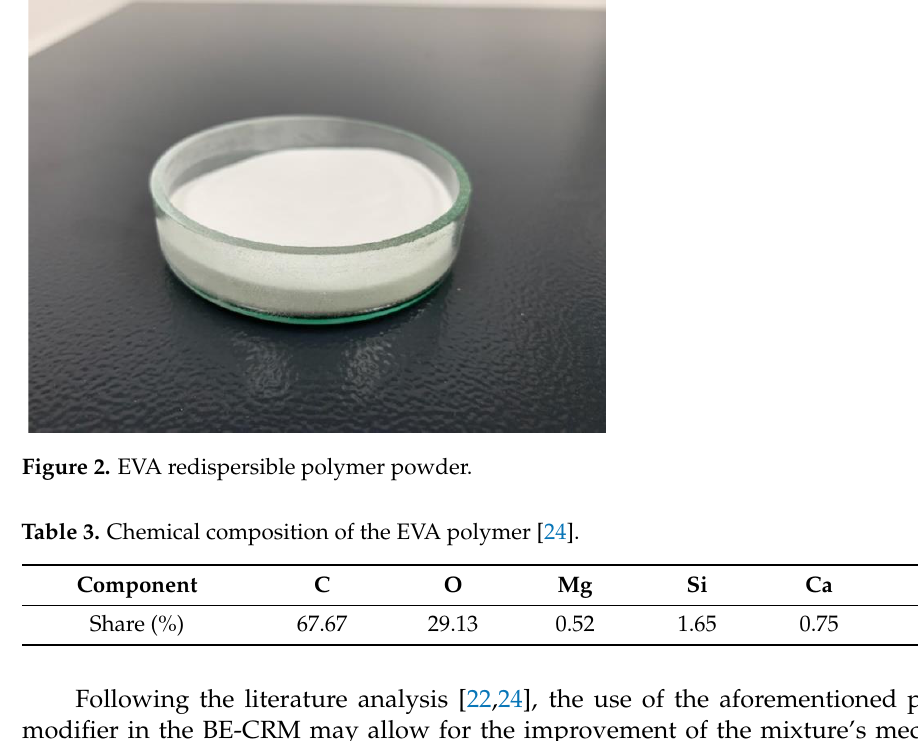
Table 4. Properties of Portland cement CEM I 42.5R.